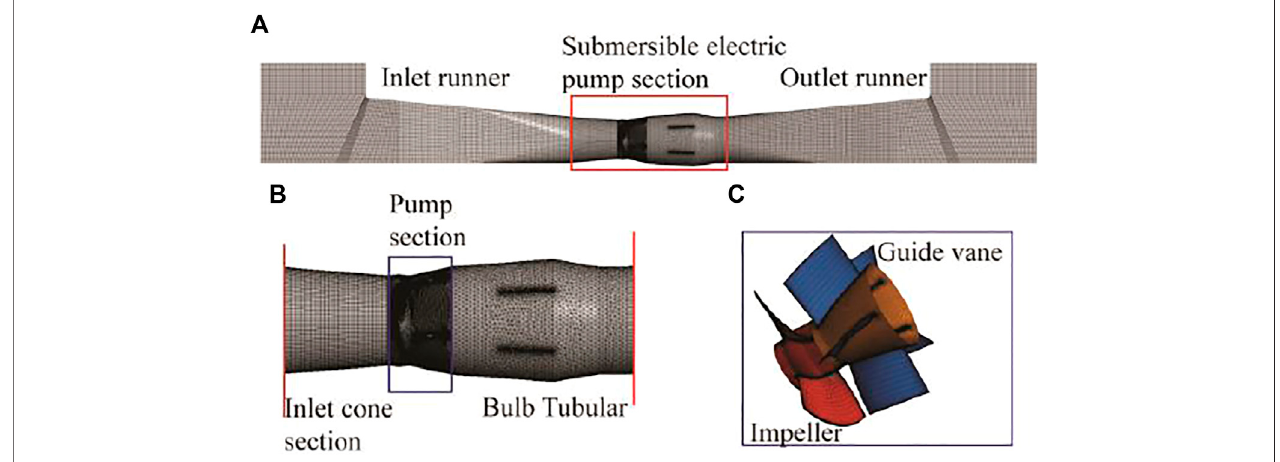
FIGURE 4 | Three-dimensional model of the submersible tubular pump device: (A) pump unit; (B) submersible electric pump section; (C) pump section.